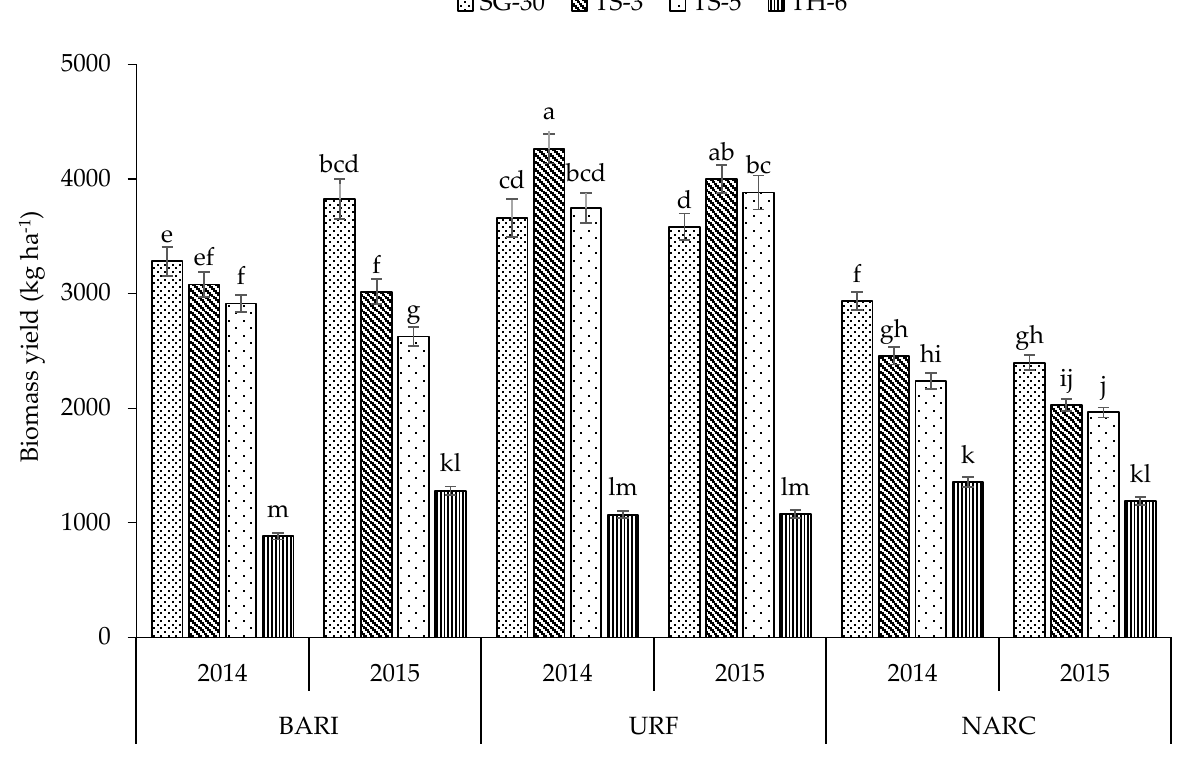
Figure 9. Biomass yield (kg ha − 1 ) of four sesame cultivars at three locations during 2014 and 2015 (pooled over micronutri- ents. The bars indicates standard error ( ± SE) of mean (n = 3). All means are significantly different at p ≤